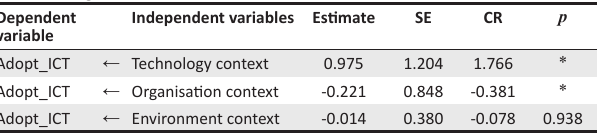
TABLE 3: Regression